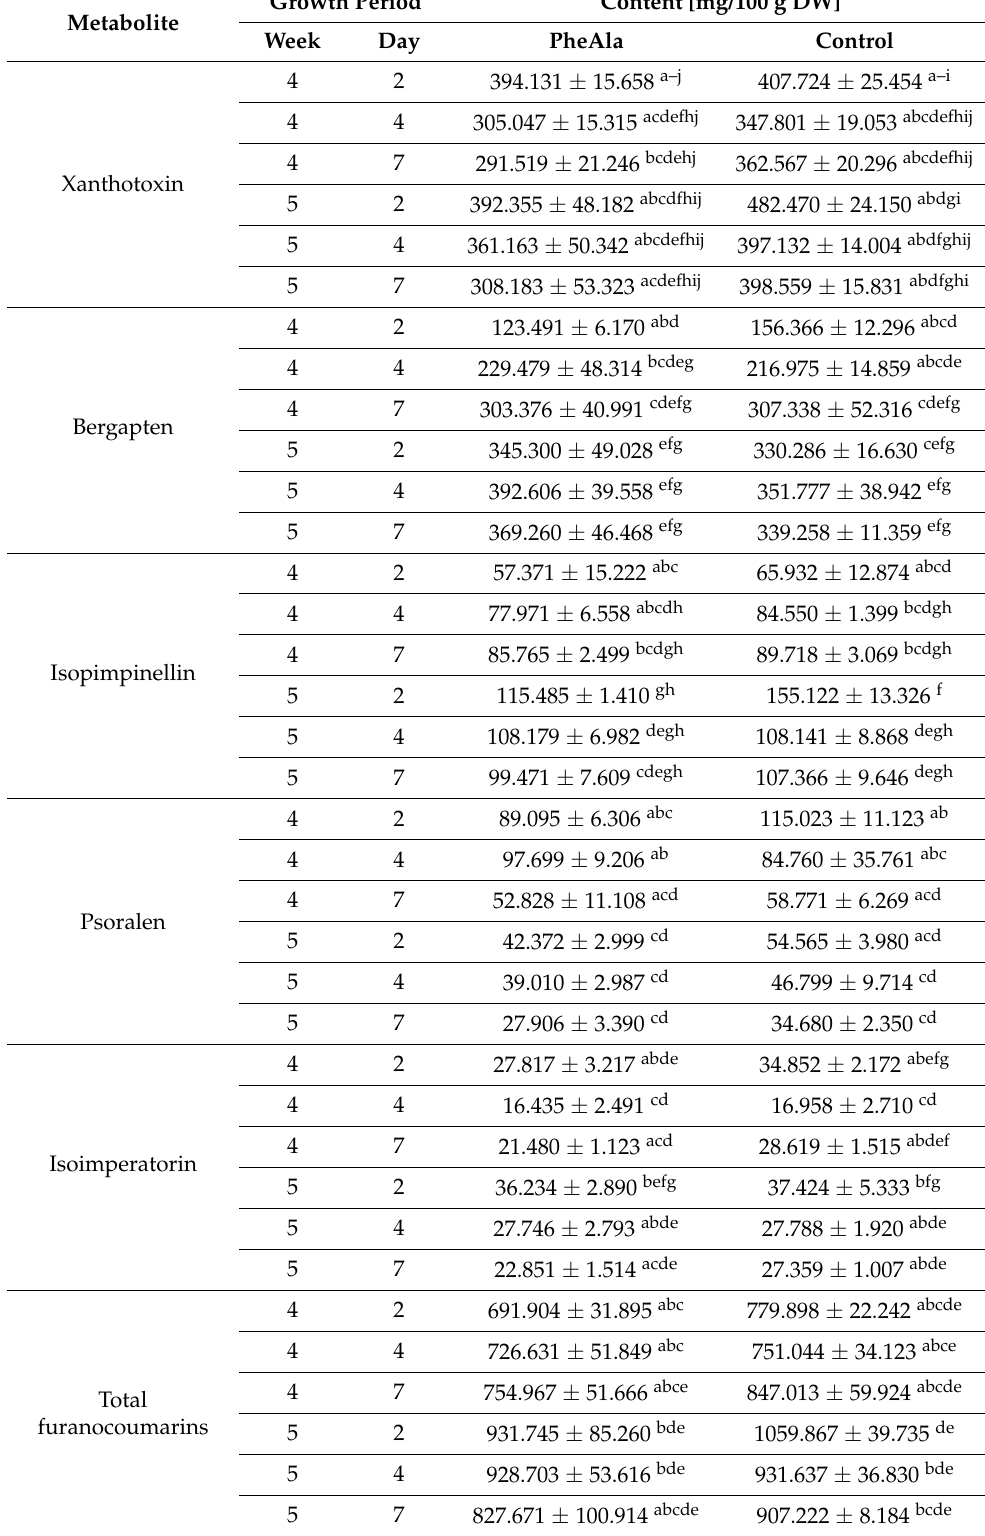
Table 3. Average content of furanocoumarins [mg/100 g DW] in methanol extracts obtained from the biomass of R. graveolens agitated cultures, depending on the duration of the growth cycle (4 and 5 weeks) and day after addition of phenylalanine (2, 3, and 7 days). Means of three